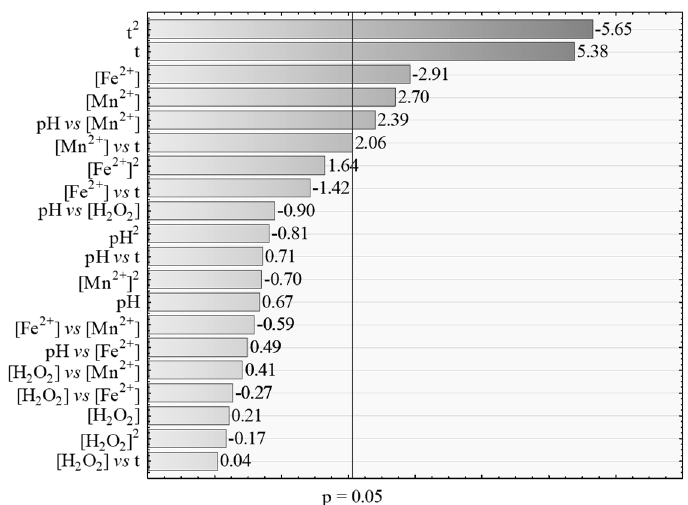
Figure 1. Pareto chart from the experimental design used (Box–Behnken), obtained for the degradation of TMP by the Fenton-like process, using Fe 2+ and Mn 2+ as catalysts.